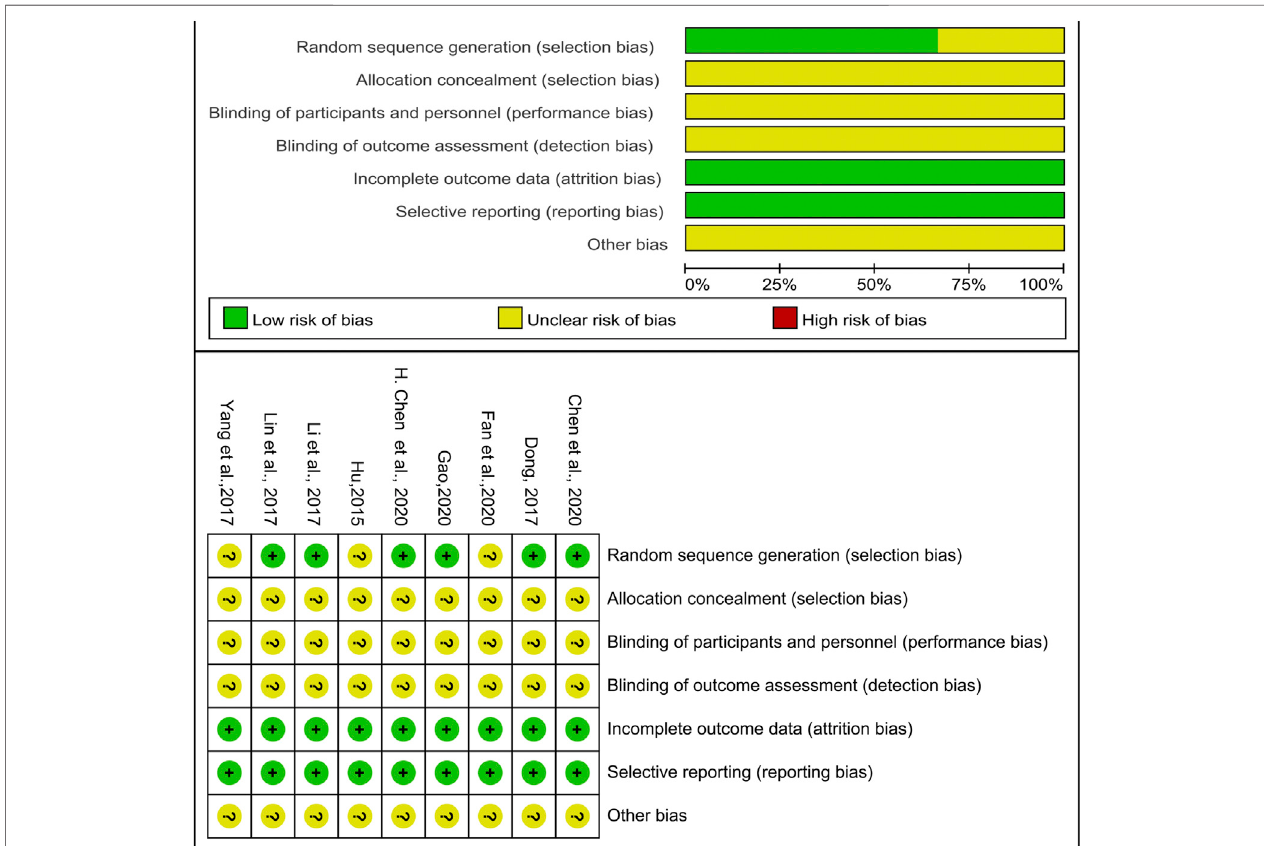
FIGURE 2 | | Risk of bias summary and risk of bias